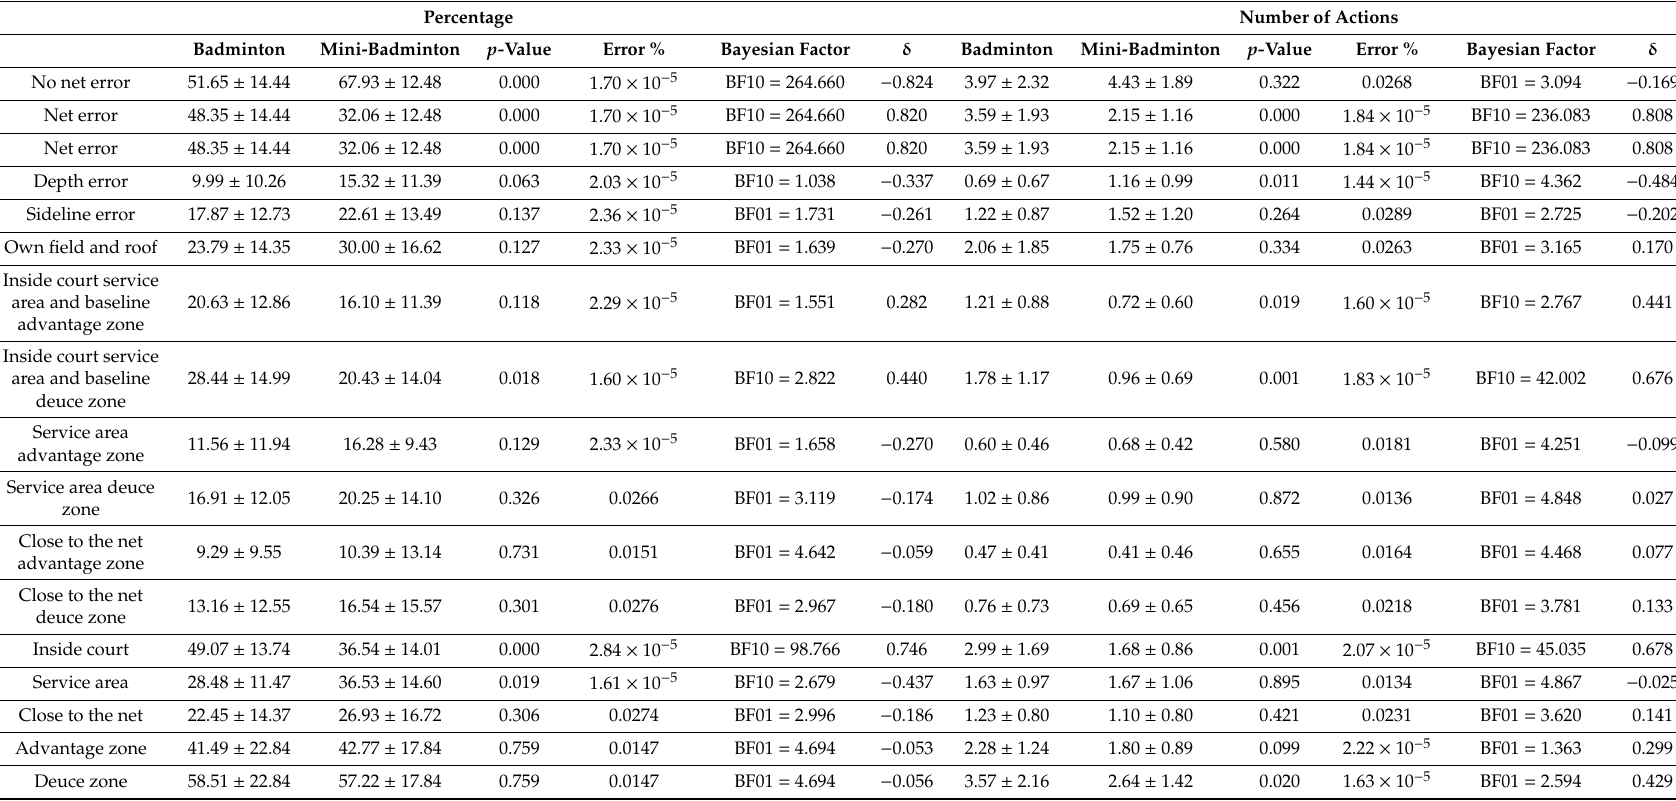
Table 6. Bayesian analysis of usage percentage and stock count technical and tactical according to shuttle landing